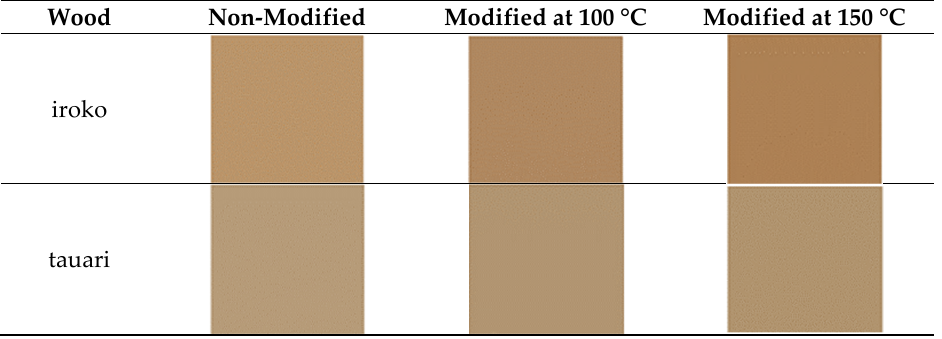
Figure 1. Iroko and tauari wood before and after thermo-mechanical modification. Table 4. Color parameters and total color change (ΔE) of thermo-mechanically modified wood; ±(SD). Modification Wood Species Temperature ( ◦ C) iroko